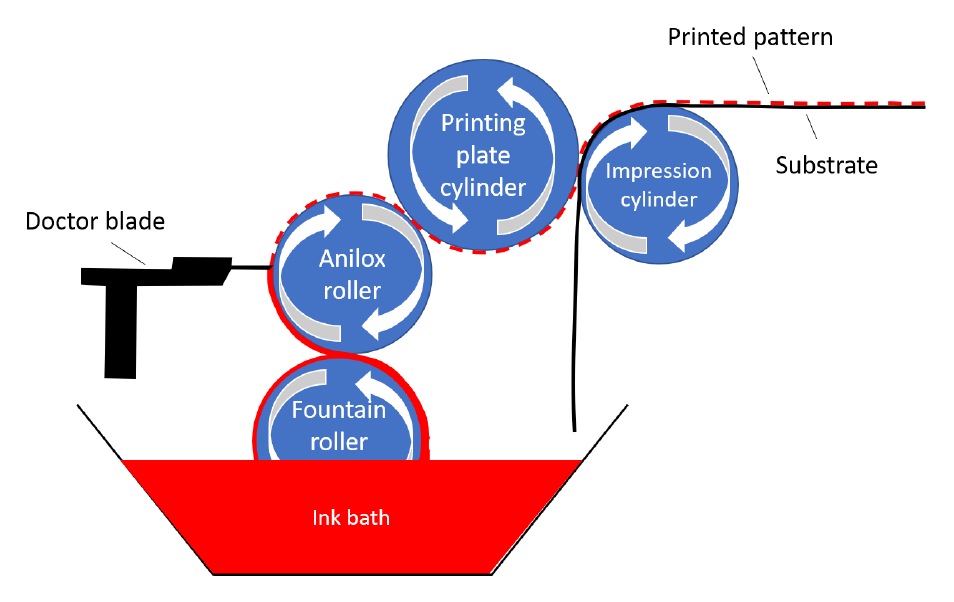
Figure 14. Schematics of